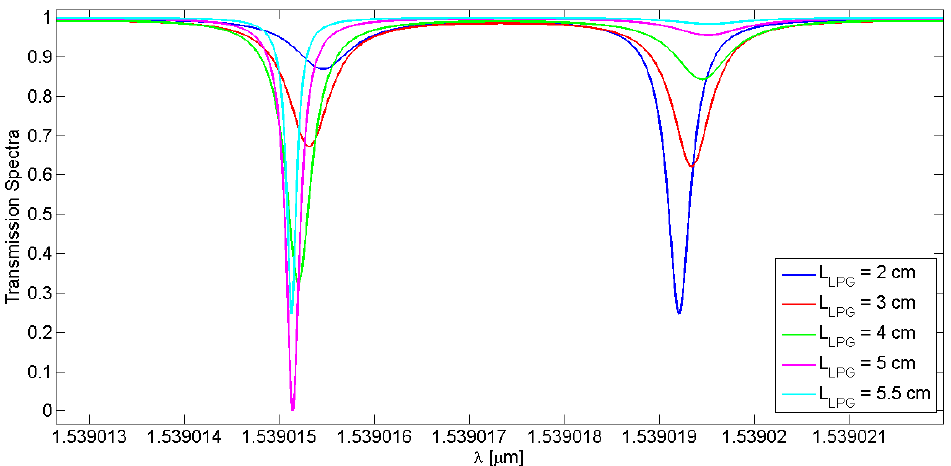
Figure 7. Transmission spectra of different LPGRRs characterized by the same core-to-cladding coupling coefficient and a LPG period of 311 µm, as a function of various grating lengths in the range from 2 cm to 5.5 cm.